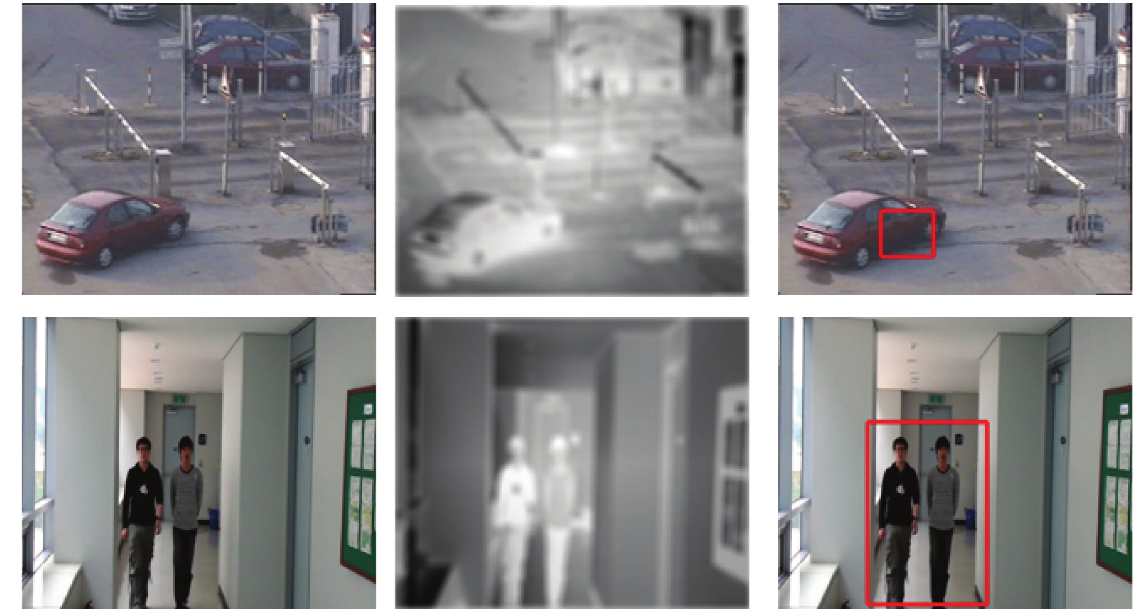
Figure 5: Videos (3) and (4): results using modified frequency tuned spatial model